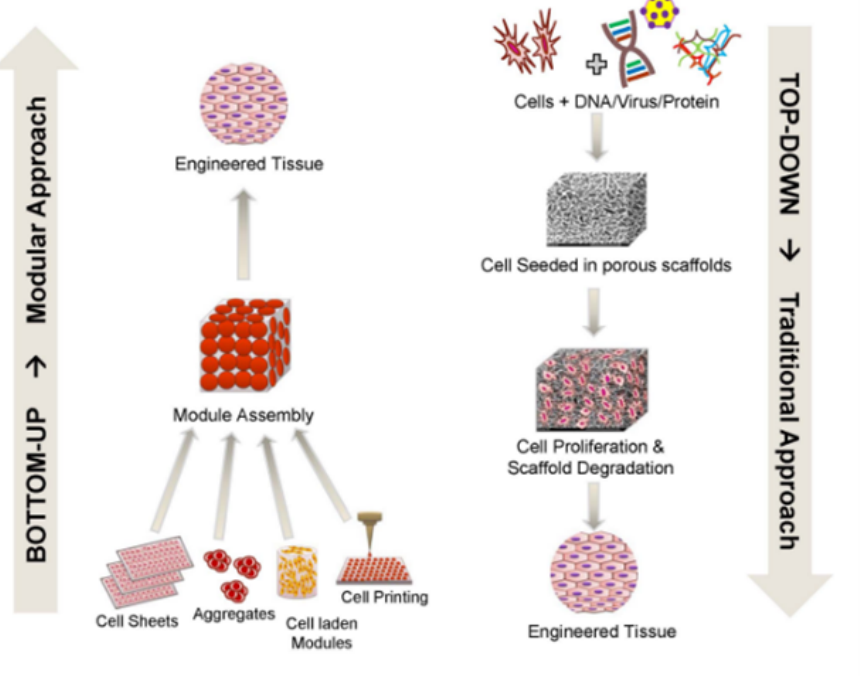
Figure 3. Comparison of top-down and bottom-up approaches for tissue